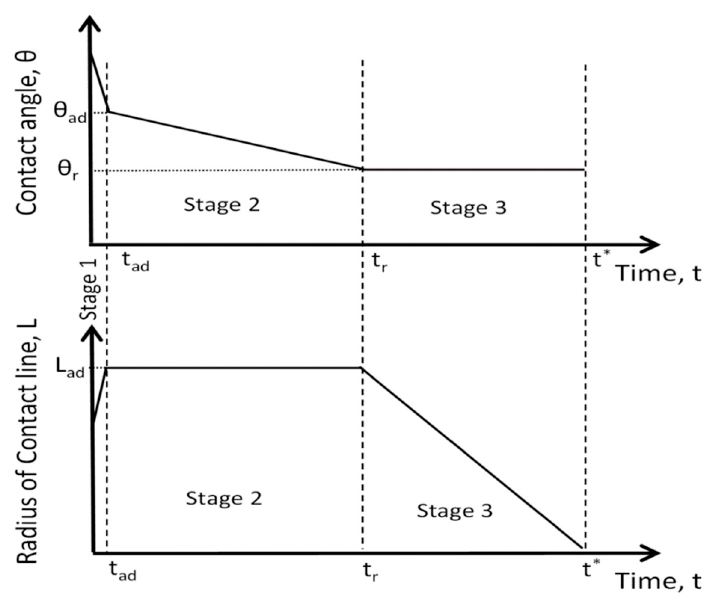
Figure 1. Three stages of spreading/imbibition of droplet over porous substrate in the case of partial wetting: L ad is the maximum radius of droplet base, θ ad is the static advancing contact angle, t ad is the time when θ ad is reached, θ r is the static receding contact angle, t r is the time when θ r is reached and t * is the time when imbibition is finished completely [13].